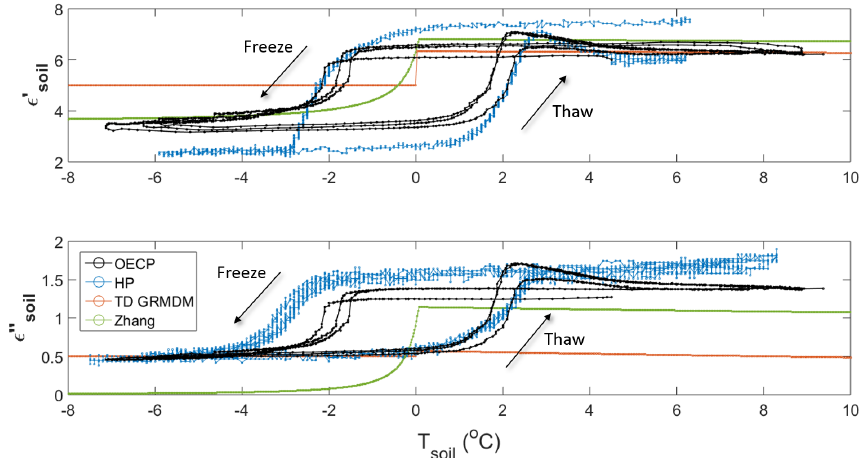
Figure 7. Same as Fig. 5 but for the loamy sand soil sample (see Table 1). Experiment conducted from 29 March to 6 April